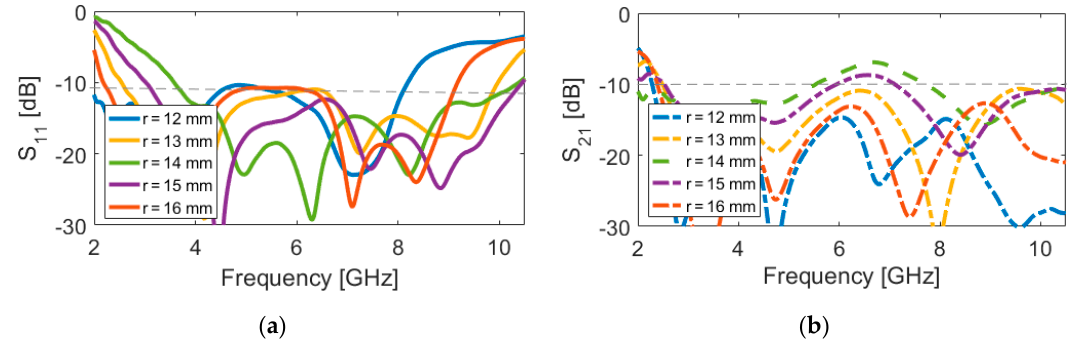
Figure 5. ( a ) S 11 and ( b ) S 21 characteristics for different values of r.